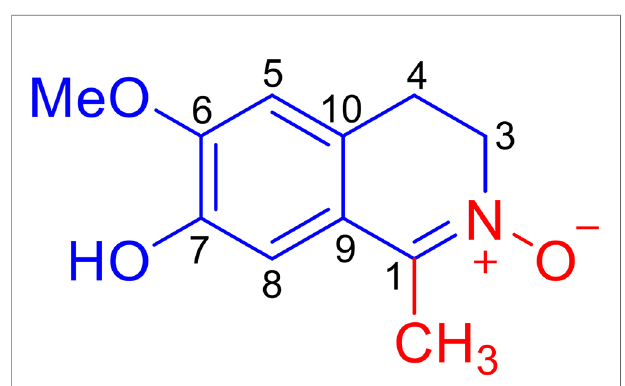
FIGURE 1 | Structure of Litcubanine A